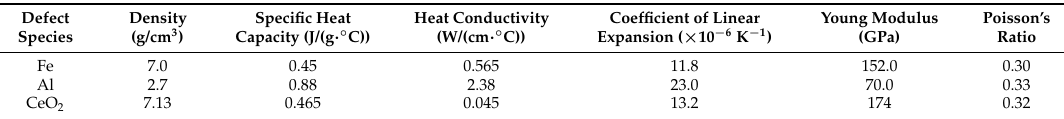
Table 2. Thermodynamic parameters of various impurity defects used in the calculation